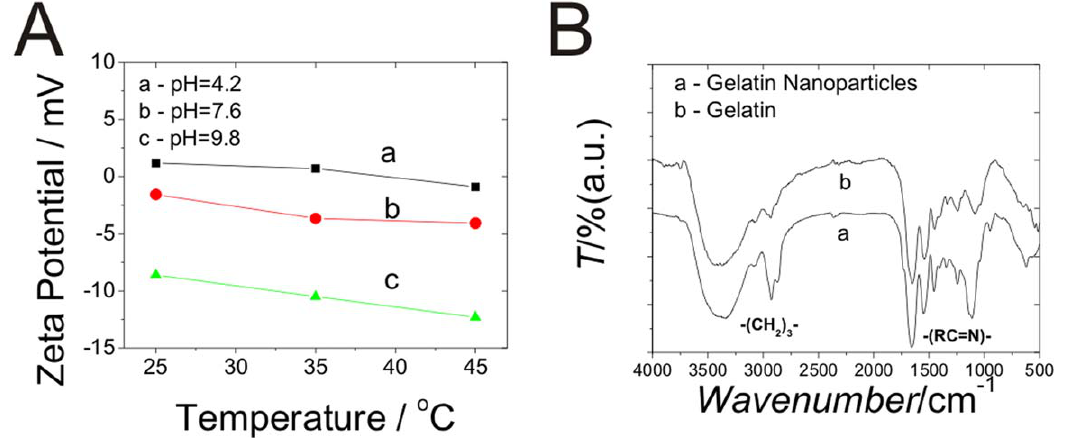
Figure 4. Characterization of CLGNs. (A) Zeta potential measurements values of the CLGNs under different temperature. (B) IR spectra of lyophilized CLGNs. Spectra of pure gelatin were also presented for comparison.